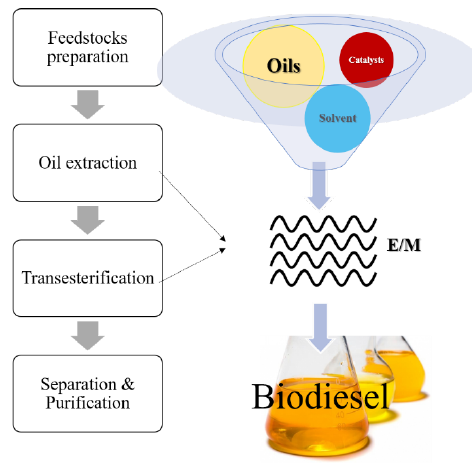
Figure 9. Microwave-assisted catalytic biodiesel production. Table 6. Experimental studies of microwave-assisted transesterification with different feedstocks.